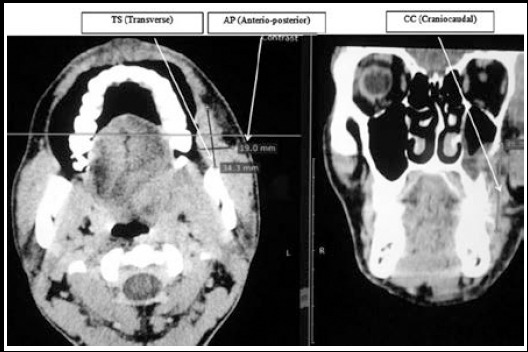
Dimensions of TS, AP and CC as marked on CT Scan Neck with contrast.